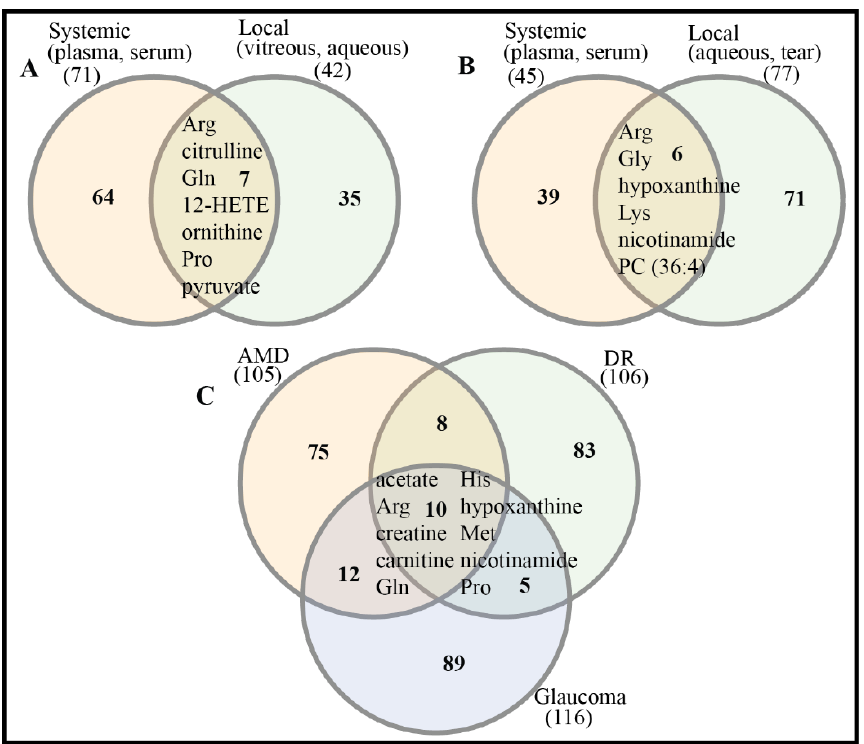
Figure 2. Comparison of differential metabolites/potential biomarkers across samples and retinal diseases. ( A ) Systemic and local samples of DR. Differential metabolites/potential biomarkers are listed in Table 2. ( B ) Systemic and local samples of glaucoma. Differential metabolites/potential biomarkers are listed in Table 4. ( C ) Three retinal diseases: AMD, DR, glaucoma. Venn plot was drawn by online tool InteractiVenn [153].